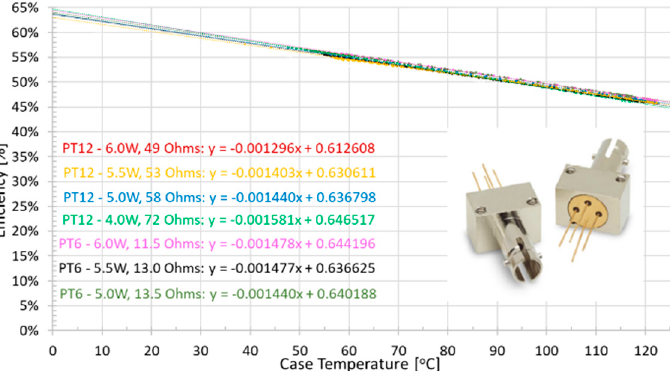
Figure 6. Measured temperature behavior for medium ‐ power PT6 and PT12 OPC devices at λ in ~ 808 nm. At P in = 6 W (average optical intensity of 41.6 W/cm 2 ), output powers greater than 3 W are obtained for T < 90 °C. The temperature coefficients are extracted from a linear fit to the measured data. The test conditions and linear regression results are indicated on the plot. Inset: picture of the medium ‐ power OPCs.